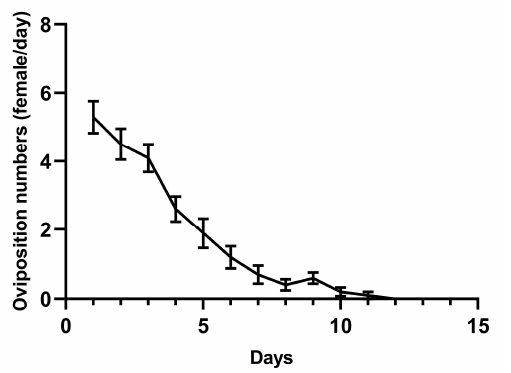
Figure 2. The daily oviposition pattern of Psyllaephagus sp. females.